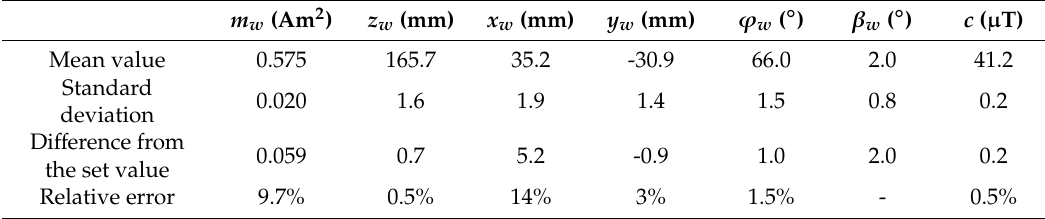
Table 1. Exemplary comparison of model and measurement results is presented in Figures 4 and 5. Table 1. ME8 measurement results, with repeatability